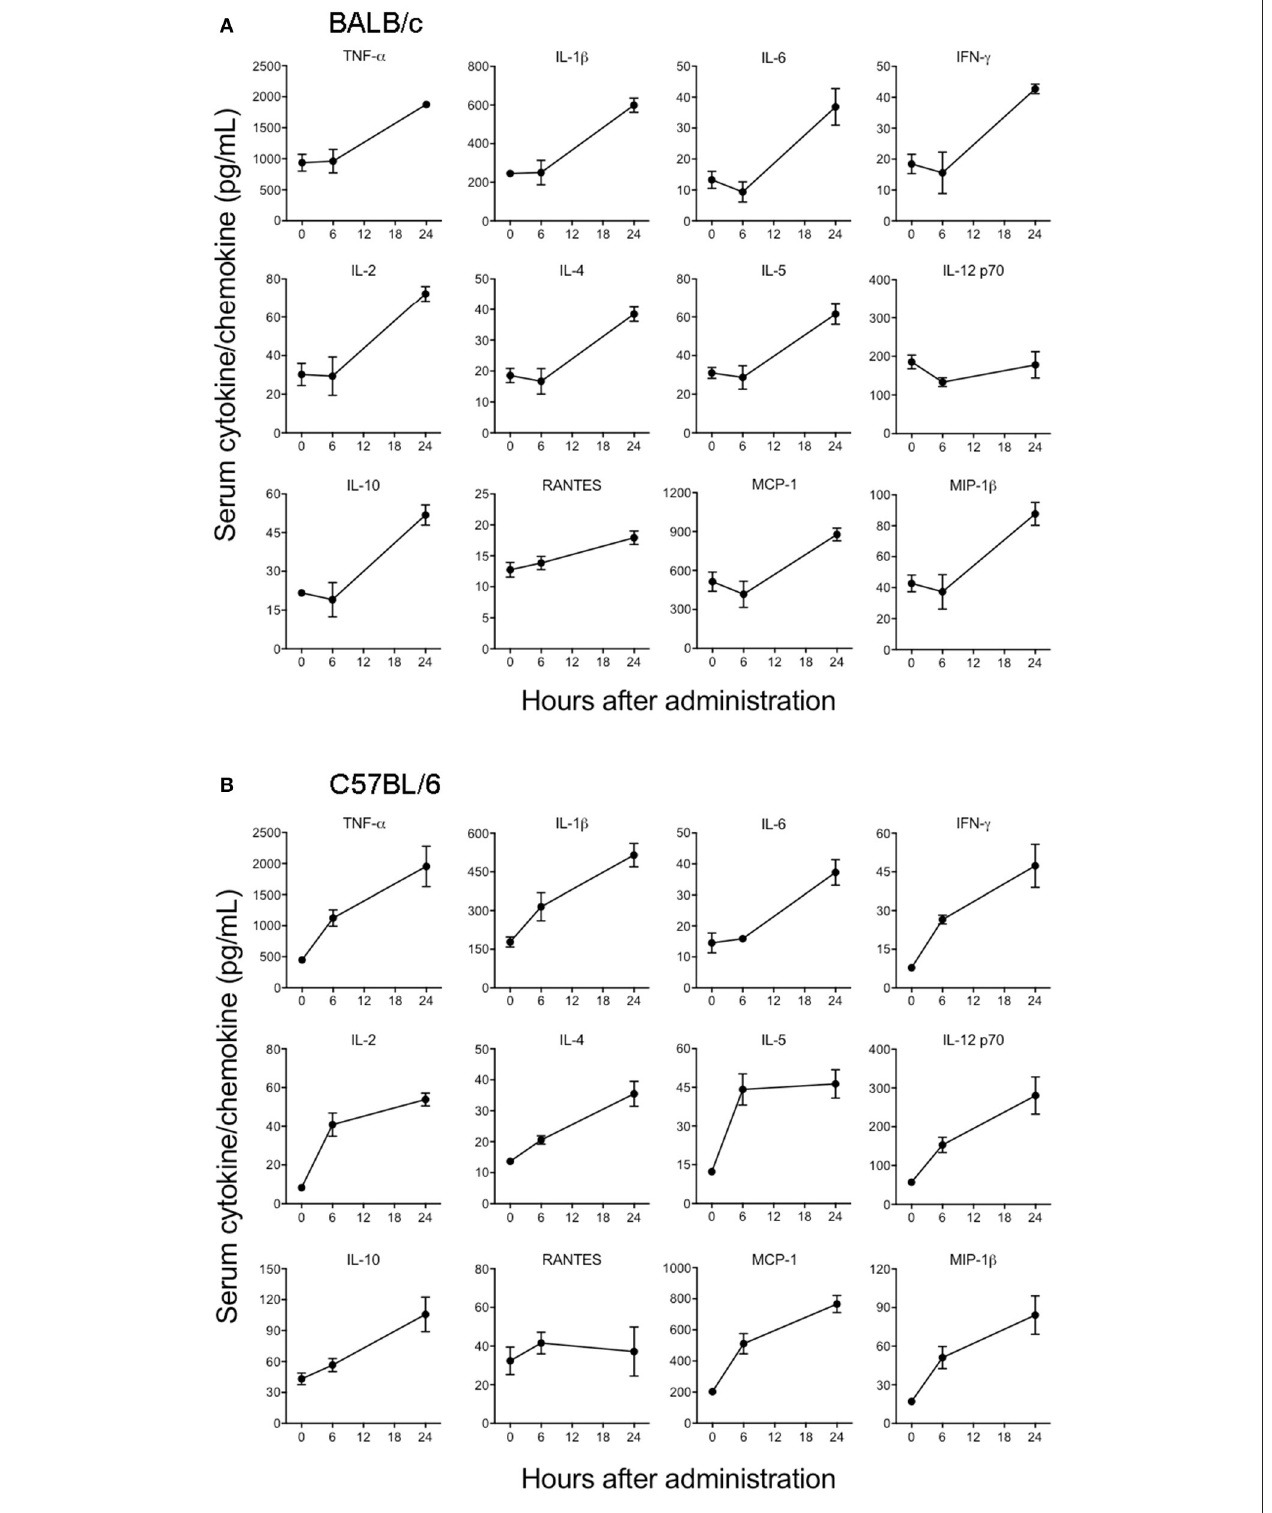
FIGURE 4 | EBOV GP stimulates the production of innate immune cytokines in mice. (A) BALB/c and (B) C57BL/6 mice were administered EBOV GP (100 µ g/mouse) via the i.p. route. Mouse serum was collected at 6 and 24 h after administration. Levels of cytokines TNF- α , IL-1 β , IL-6, IL-2, IL-4, IL-5, IFN- γ , IL-12, IL-10, and chemokines MCP-1, MIP-1 β , and RANTES were measured using a multiplex Luminex assay. The data are expressed as the mean concentration (pg/mL) ± SEM observed in serum samples from 3 animals per group.